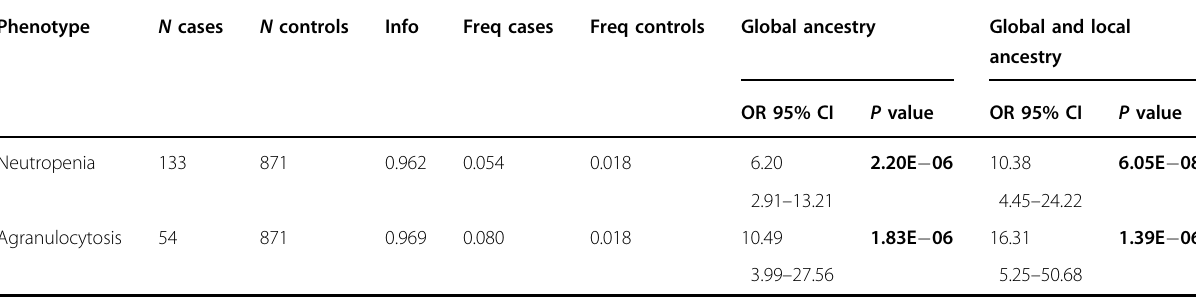
Table 2 Results of association analyses of rs113332494 for neutropenia and agranulocytosis including 1004 and 925 individuals of European ancestry.